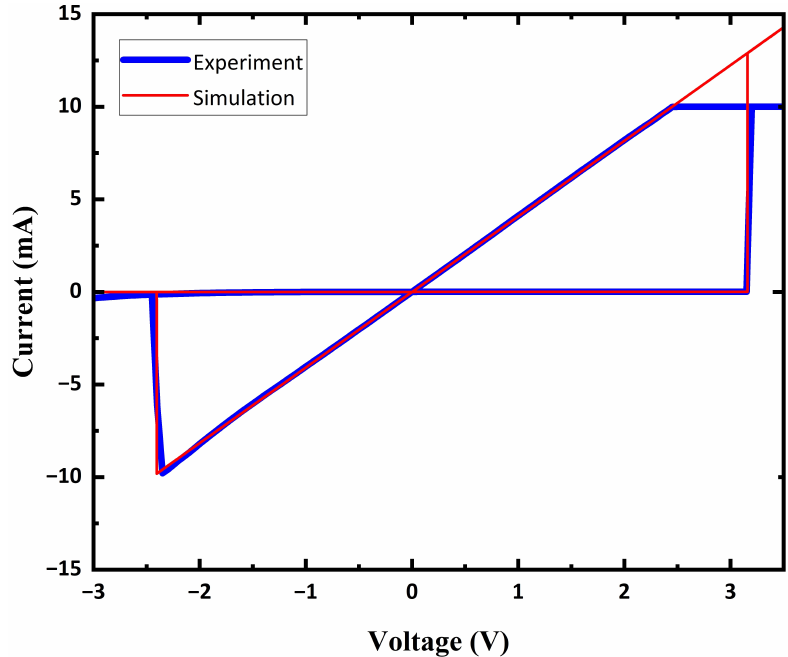
Figure 6. Electrical characteristics of Au/Ni/HfO 2 /Ni RRAM obtained from experiment and